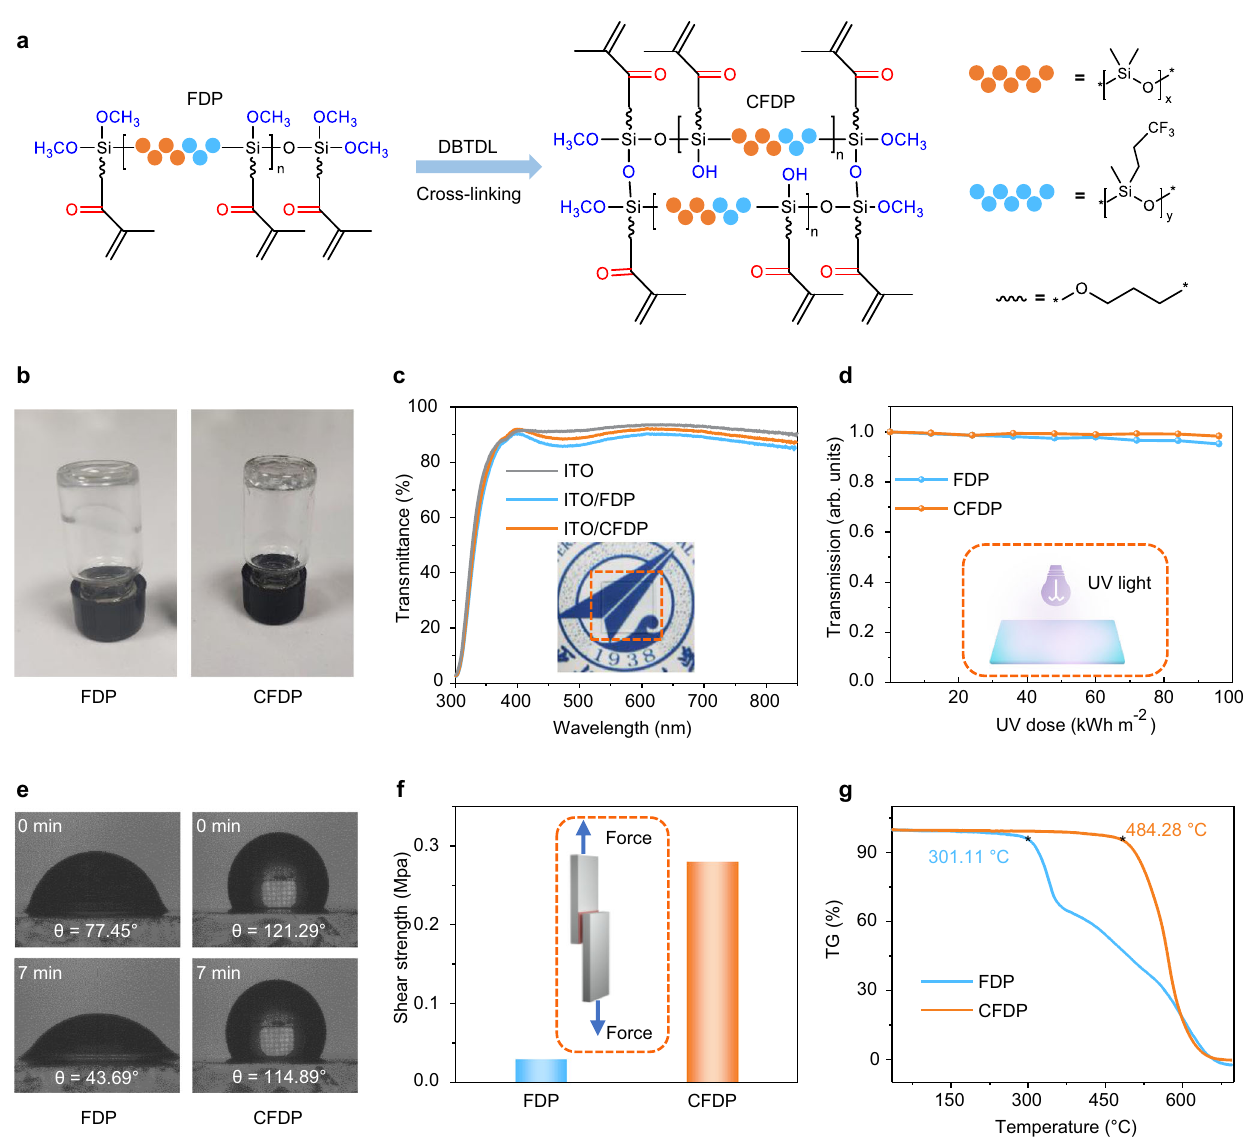
Fig. 1 | Characterization of FDP and CFDP. a The synthetic route of polymer gel CFDP. b Photographs of the fl uorosilicone polymer before (FDP) and after (CFDP) theself-crosslinkedprocess. c ThelighttransmittanceofITOglasswithoutandwith the FDP and CFDP (thickness of 800 μ m). The picture of polymer gel CFDP with a 15mm-by-15mm area on an ITO glass substrate is shown in the inset (indicated by orange dashed line). d The UV stability of FDP and CFDP. The UV stability test is